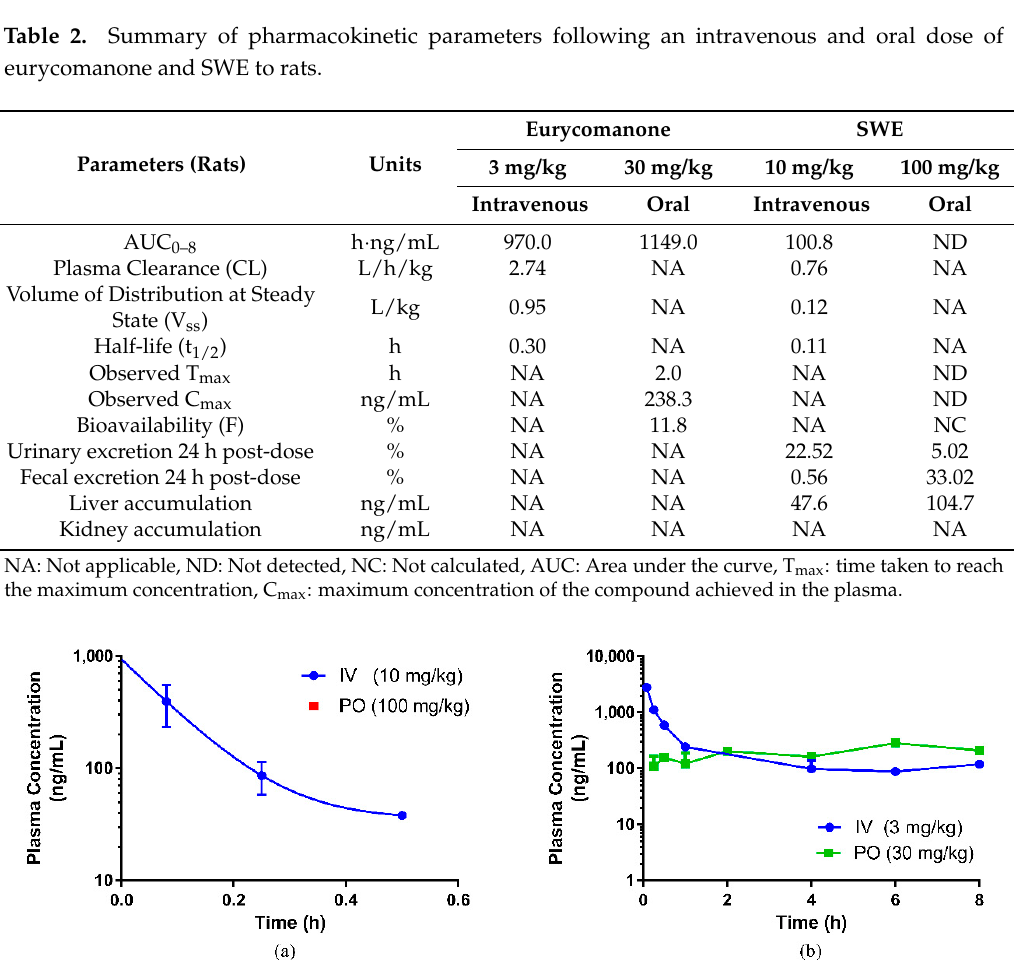
Table 2. Summary of pharmacokinetic parameters following an intravenous and oral dose of eurycomanone and SWE to rats.